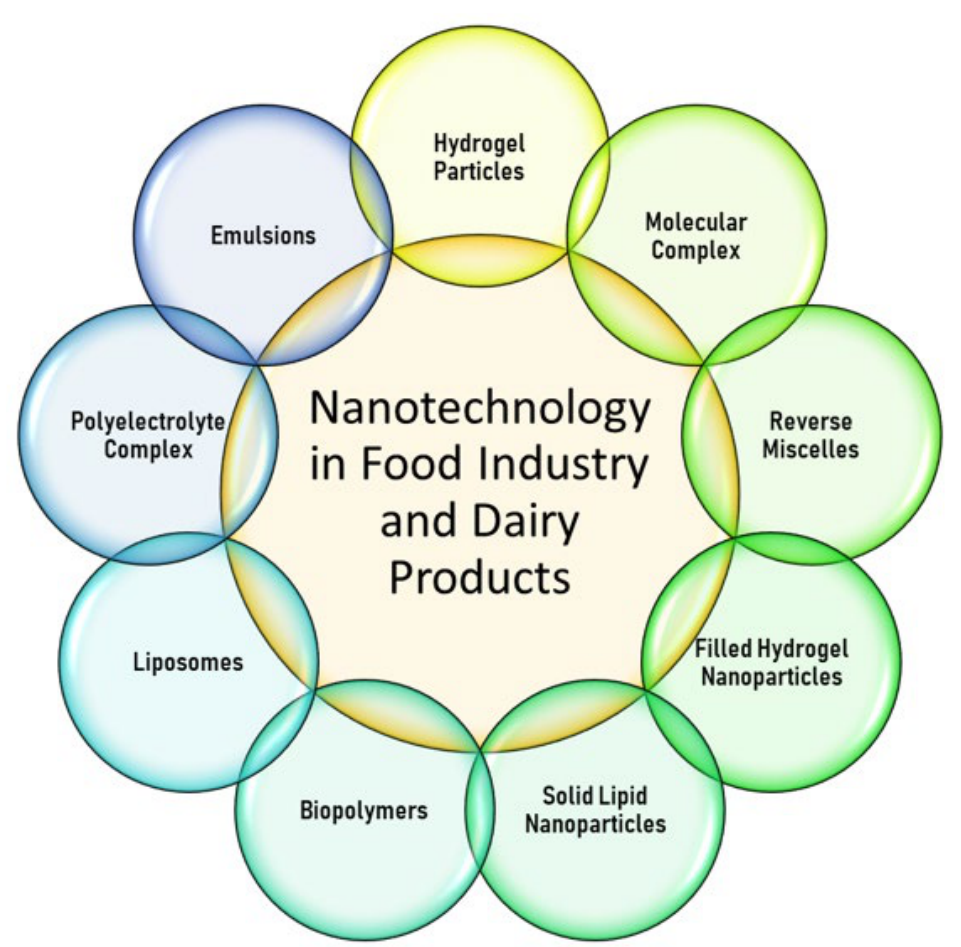
Figure 1. Different applications of nanotechnology in food industry and dairy products (Adapted from Nile et al. [31]).